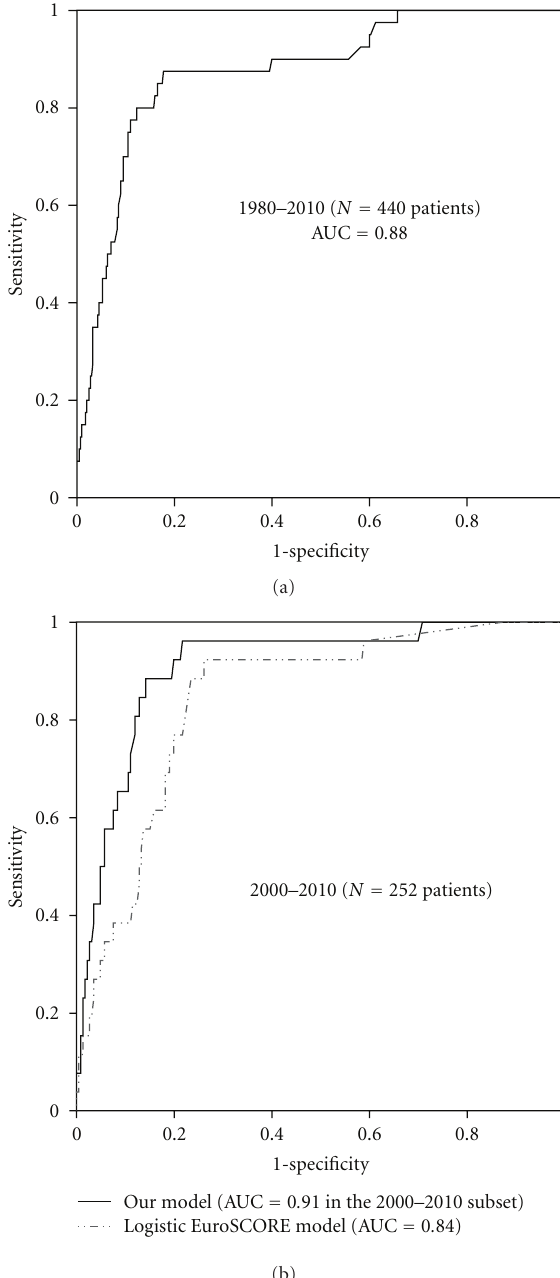
Figure 1: (a) Receiver-operator characteristic (ROC) curve for our logistic regression model developed from the analysis of 440 native valve IE patients: note the high value of the AUC, also compared to the one reported in the EuroSCORE development study (0.78 [8]); (b) ROC curves for our logistic regression model and the logistic EuroSCORE in the subpopulation (2000–2010) for whom EuroSCORE data were available; AUC: area under the